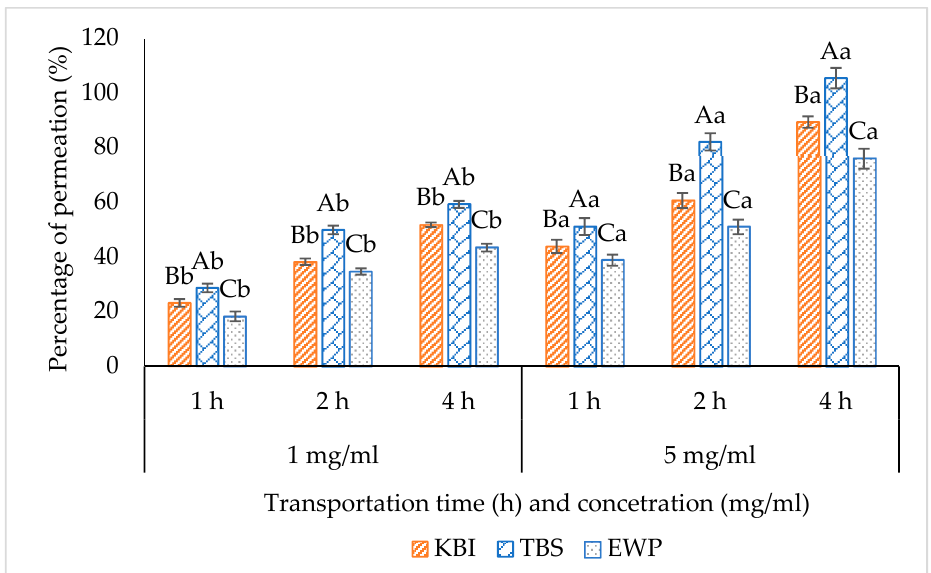
Figure 6. Percentage of permeation of red kidney bean protein (RKB), threadfin bream surimi (TBS) and egg white protein (EWP) at different concentration and its corresponding Caco-2 cell monolayer permeates collected from basolateral at different transportation time. Different uppercase letters on the bars within the same transportation time and concentration denote significant differences between the samples ( p < 0.05). Different lowercase letters on the bars within the same transportation time denote significant differences between different concentrations ( p < 0.05). Error bars represent standard deviation ( n = 3).